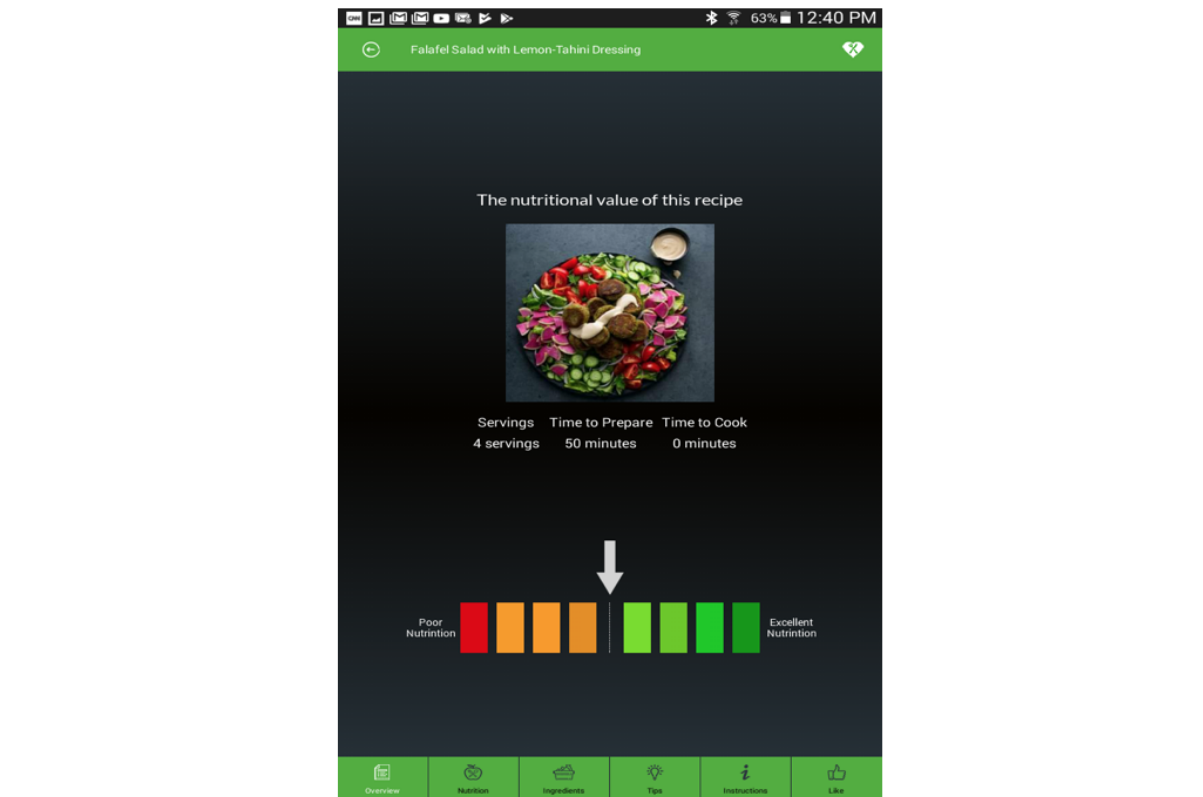
Figure 4. The overall nutritional value of the “Falafel salad”